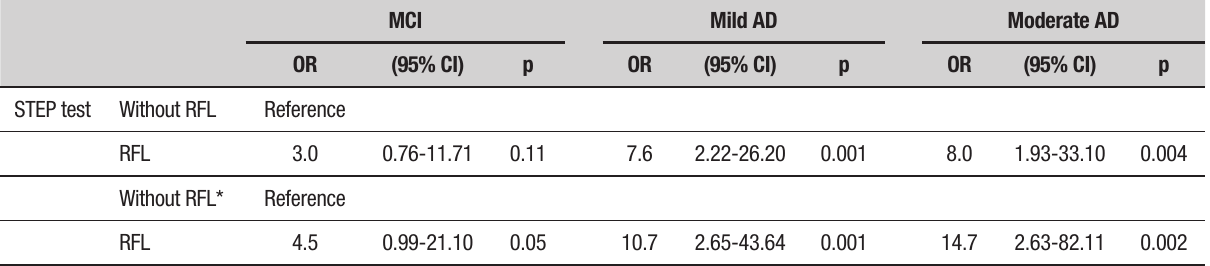
Table 3. Association between Risk of Functional Loss (RFL) on STEP test and diagnosis of MCI and